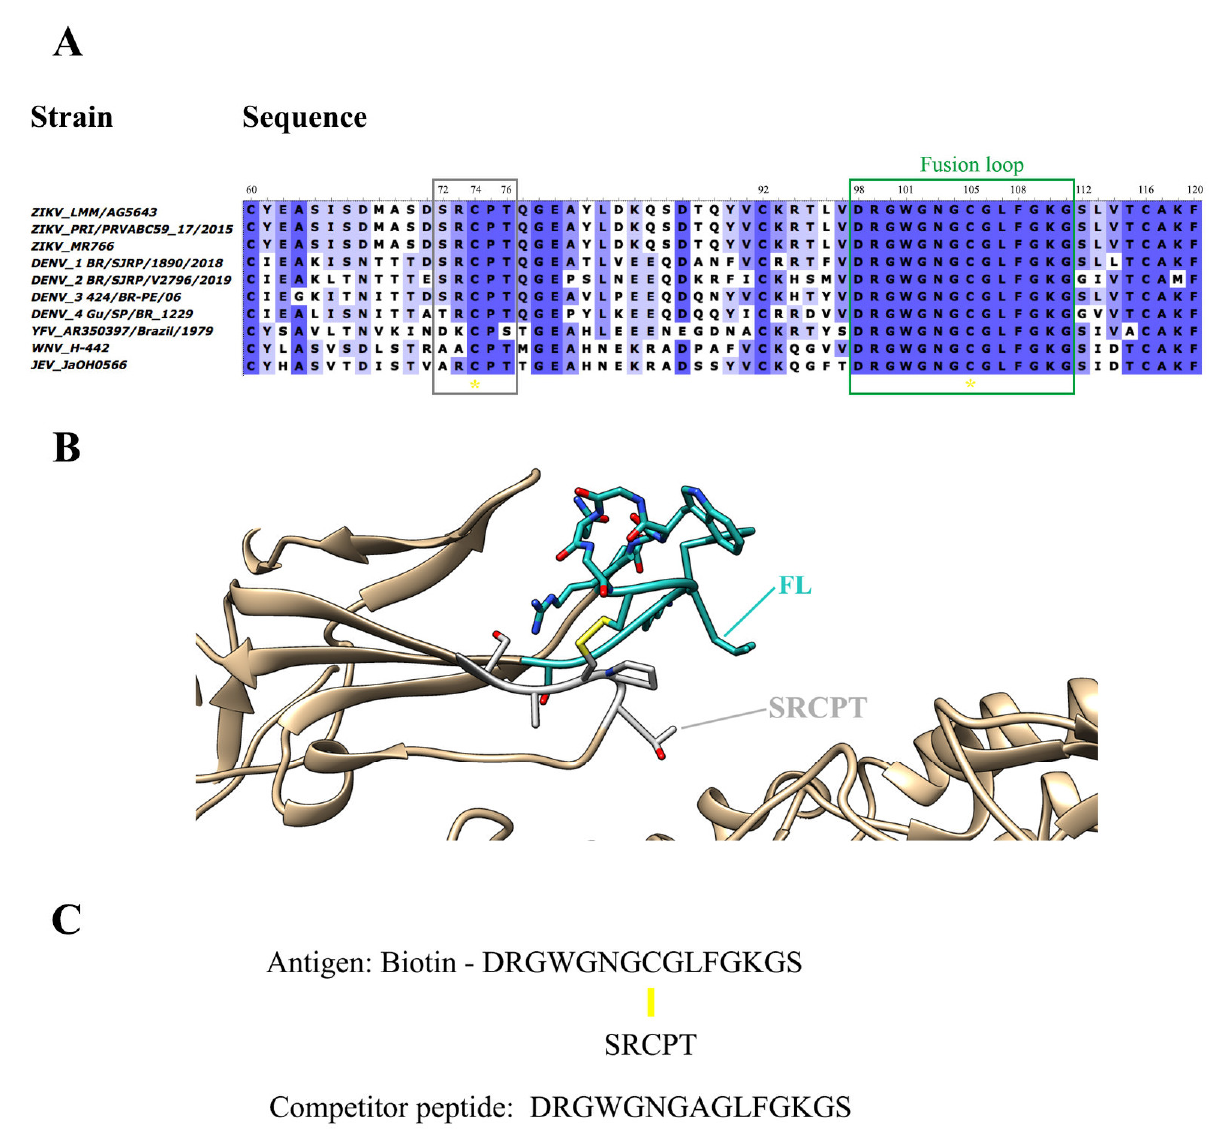
Figure 1. Design of antigen for the selection of antibodies anti-FL. ( A ) Antigen design was based on the alignment of the fusion loop sequences (green rectangle) found in the Protein E Domain II from different flaviviruses strains. A disulfide bridge connects the FL sequence to the SRCPT peptide (gray rectangle). Yellow asterisks highlight the conserved cysteines. ( B ) Structural representation of the FL (cyan) in the ZIKV protein E domain II. On the viral envelope, FL projects outward domain II is underpinned by the SRCPT peptide (grey) by a disulfide bridge bond (highlighted in yellow). ( C ) Peptide sequences of the selection antigen with FL, peptide SRCPT and Biotin, and competitor peptide with only FL (with an Ala substituting for Cys) are used for competitive elution. Yellow line: disulfide bridge.